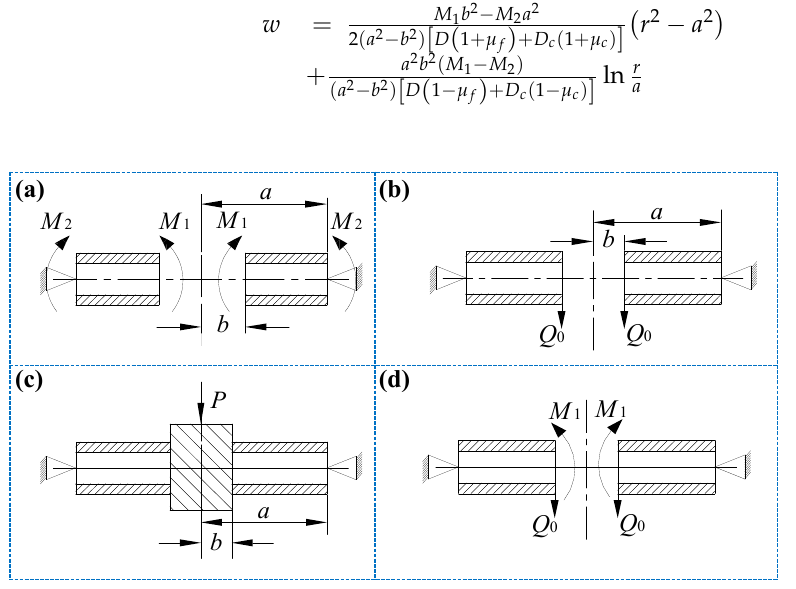
Figure 3. Boundary constraint conditions and loading conditions for annular SP-HC: ( a ) uniformly distributed bending moments M 1 and M 2 acting on the outer boundary simply supported, inner and outer boundaries, respectively; ( b ) simply supported at the outer boundary and uniform shear force Q 0 acting along the inner edge; ( c ) simply supported at the outer boundary and fixed-end supported at the inner edge; ( d ) force diagram of the circular plate simply supported at the outer boundary and fixed-end supported at the inner edge.